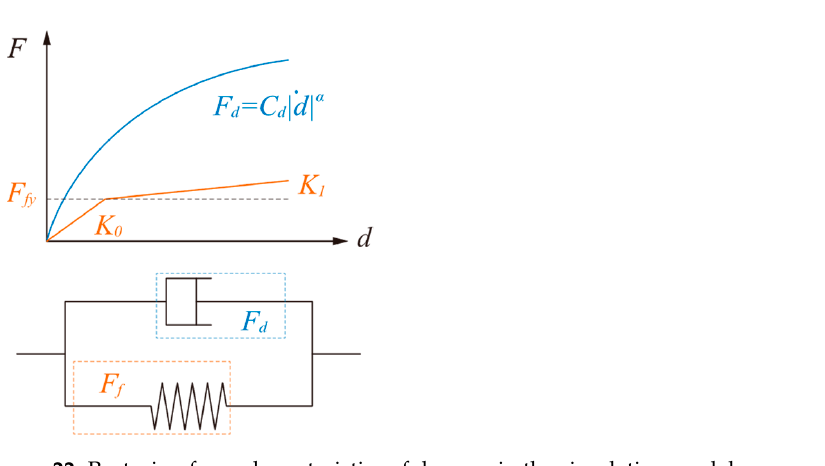
Figure 21. Analytical model in the STERA 3D.